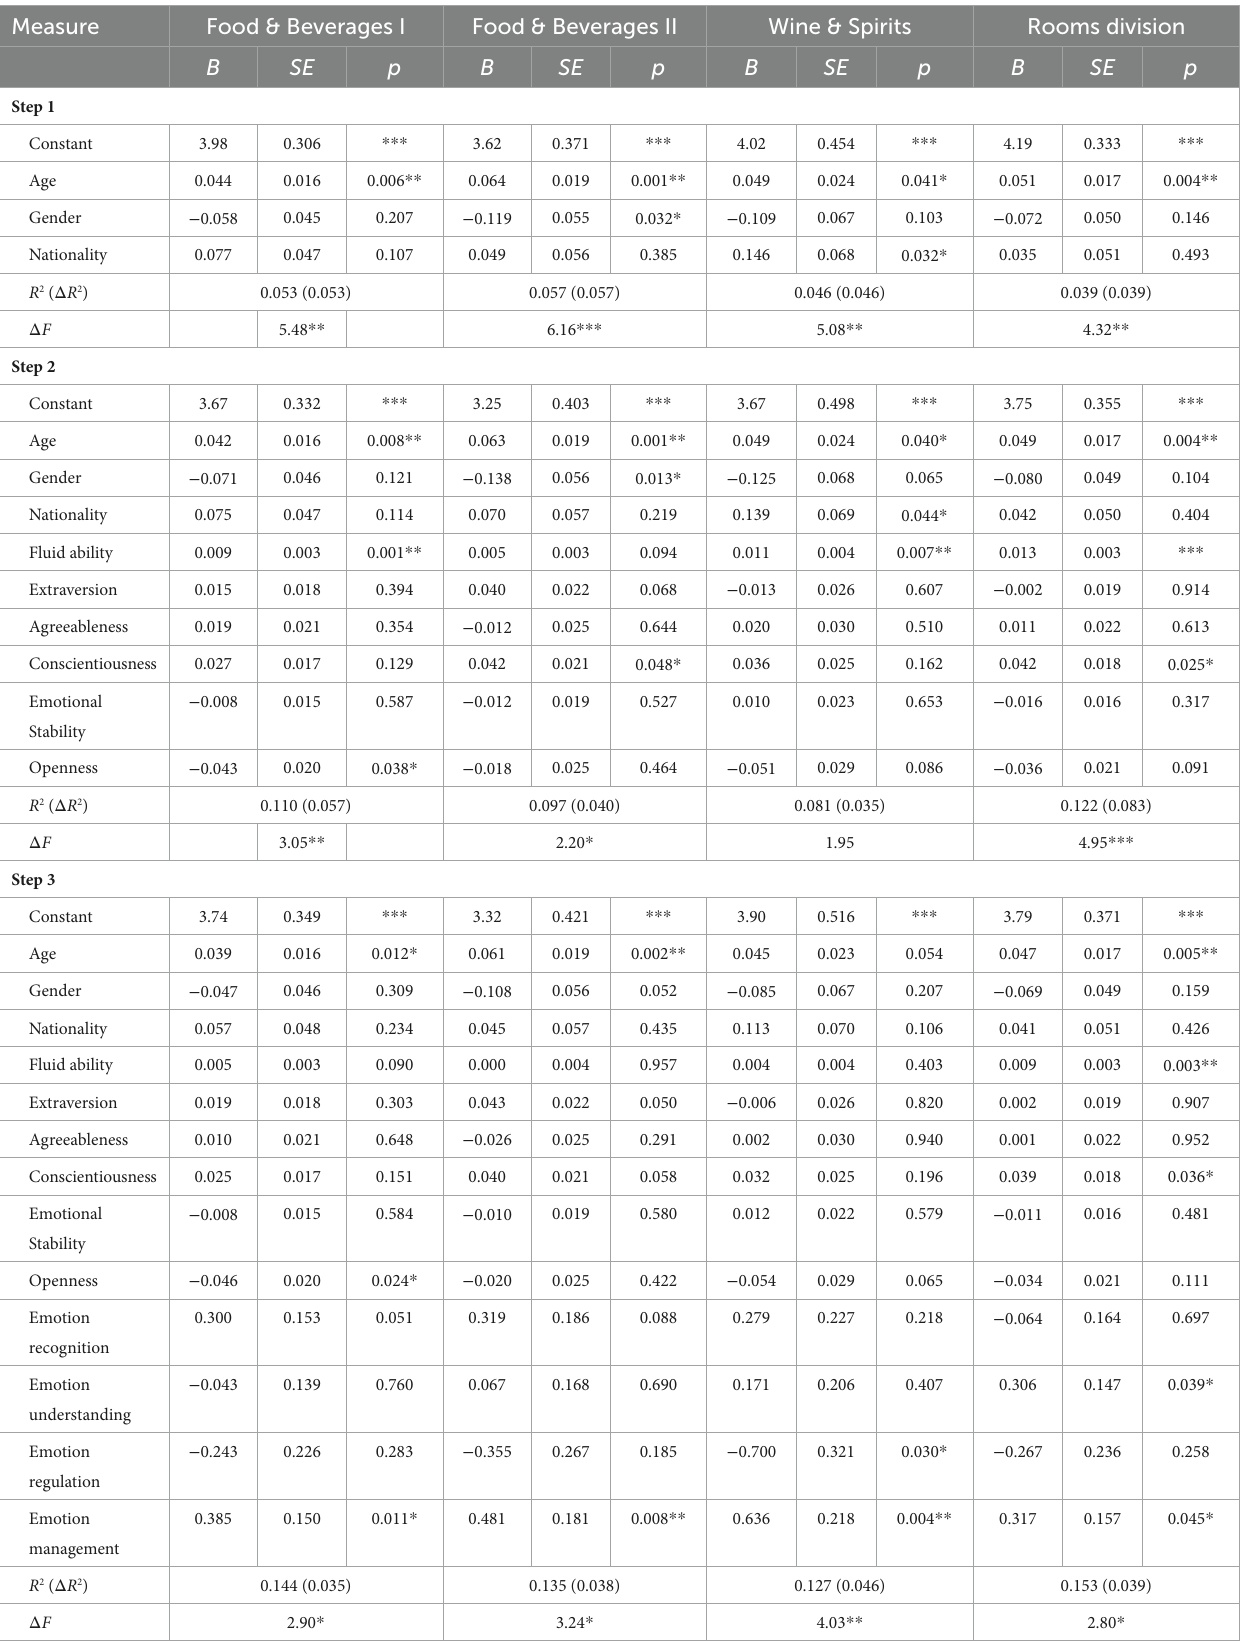
TABLE 4 Hierarchical regression of demographics, fluid ability, personality, and emotional abilities onto module grades. Measure Food & Beverages I Food & Beverages II Wine &